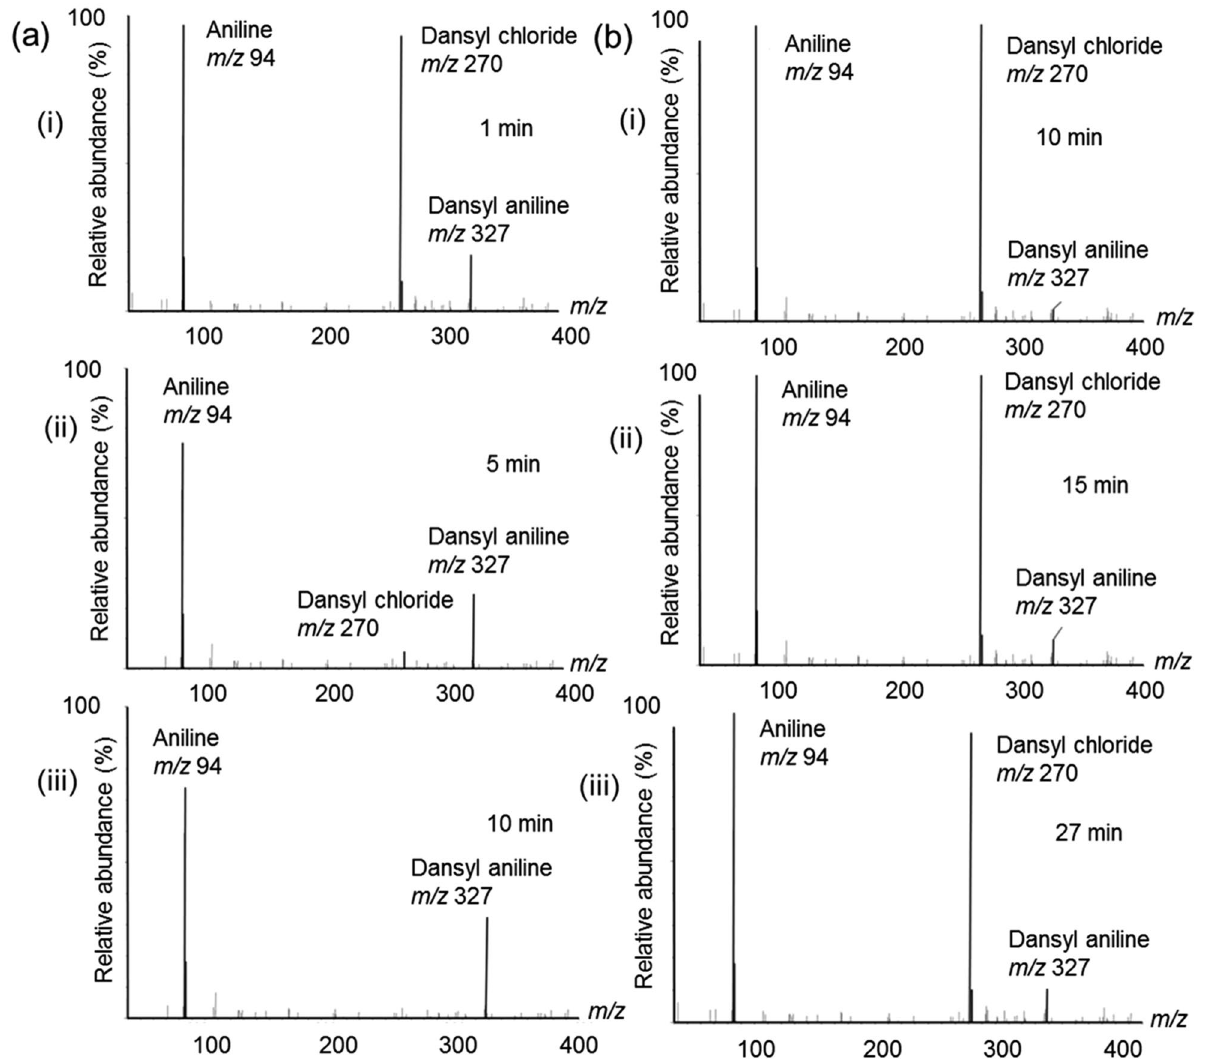
Figure 2. Time-resolved mass spectra showing the synthesis of dansyl aniline (protonated molecular product ion indicated at m / z 327). Unreacted aniline and dansyl chloride are evident from their respective mass spectral peaks: [aniline + H] + at m / z 94 and [dansyl chloride + H] + at m / z 270. Three distinct time intervals are given, as indicated by (i)–(iii) which are given in the subfigures for both: ( a ) single tip (conventional) PSI-MS and ( b )